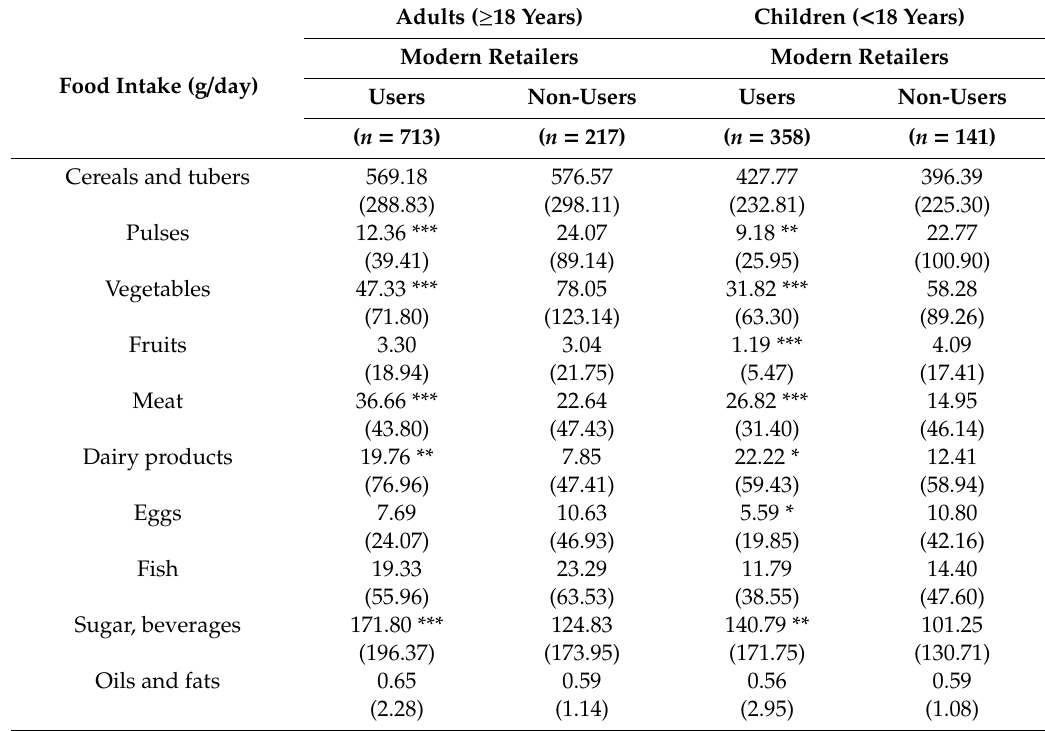
Table 1. Per capita food intake of adults and children using and not using modern